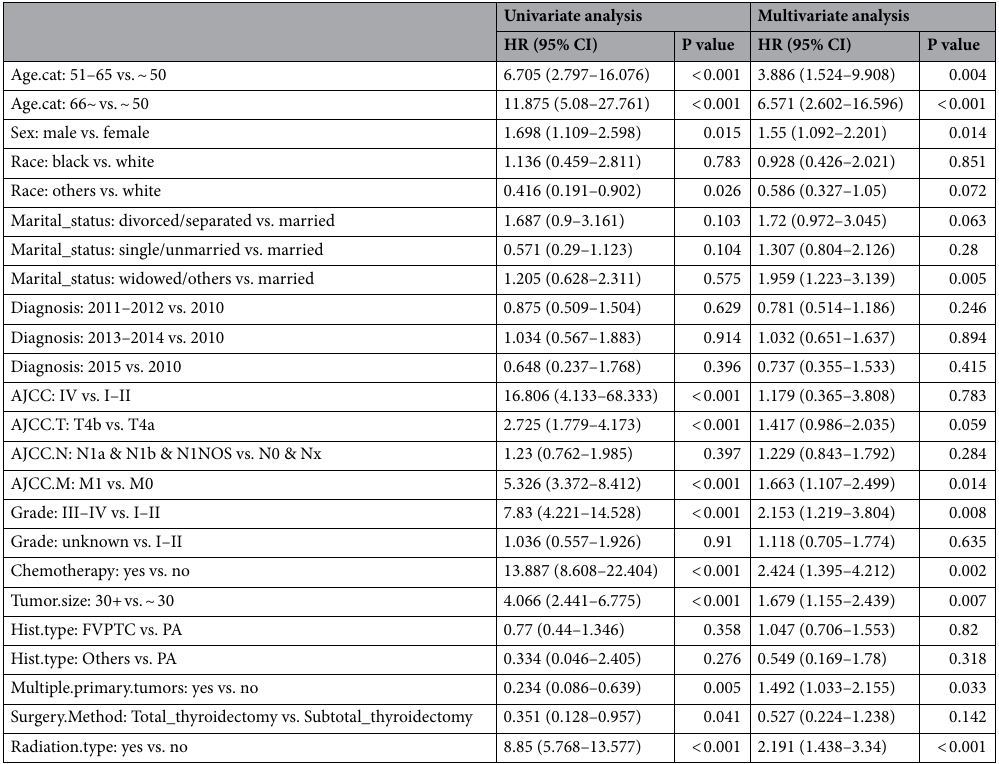
Table 3. Cox regression: univariate analysis and multivariate analysis of disease-specific